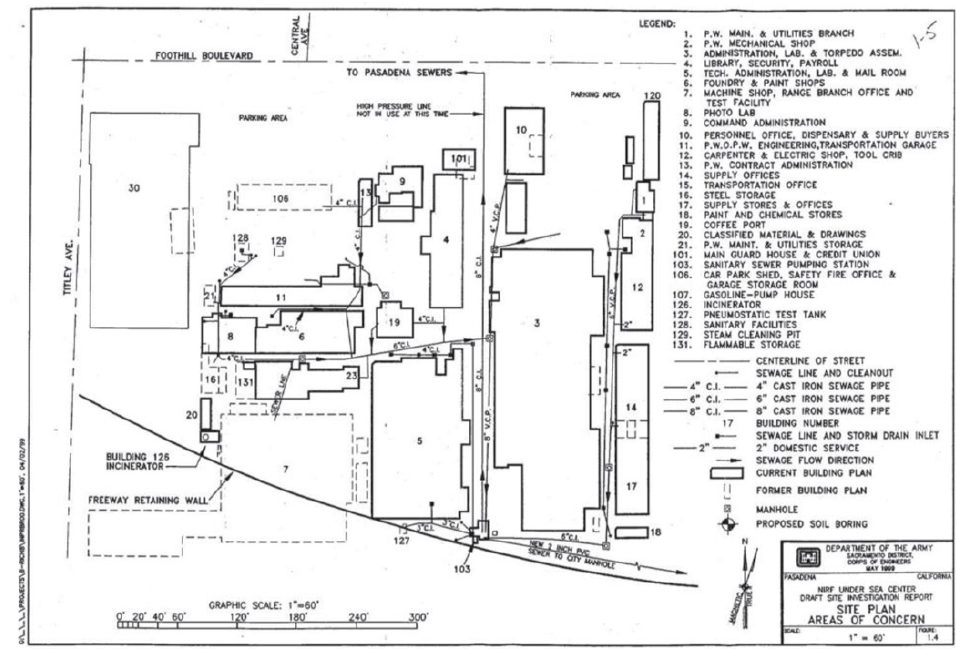
Figure 1. Map of the former US Naval Ordnance Test Station, Pasadena. (Map is from US Army Corps of Engineers, Draft Site Investigation Report, NIRF Under Sea Center Site Inspection, Figure 1.4).